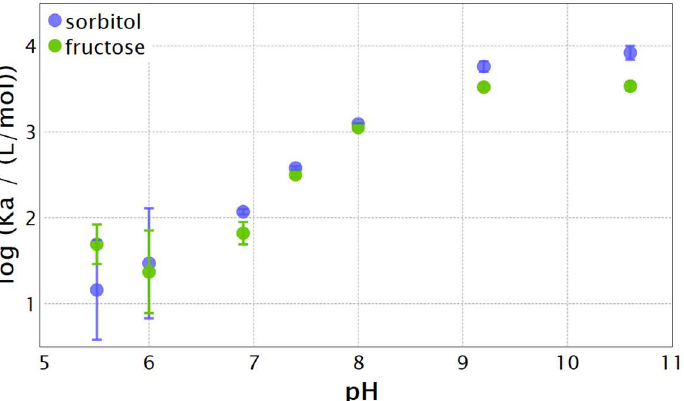
8.0 the values of binding constants 818 ± 89 L/mol and 513 ± 5 L/mol for PBA and TBA correspondingly were obtained.